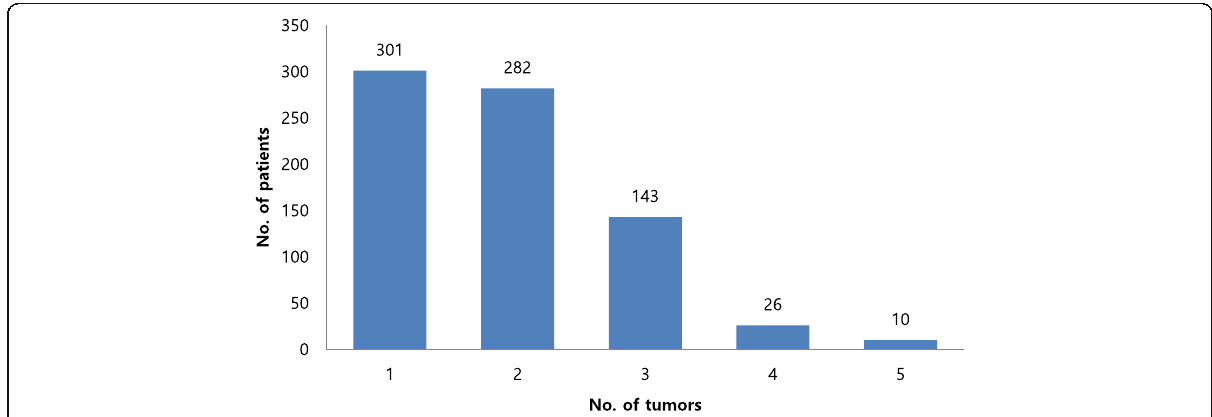
Fig. 1 Distribution of 762 patients according to the number of tumors within the prostate gland